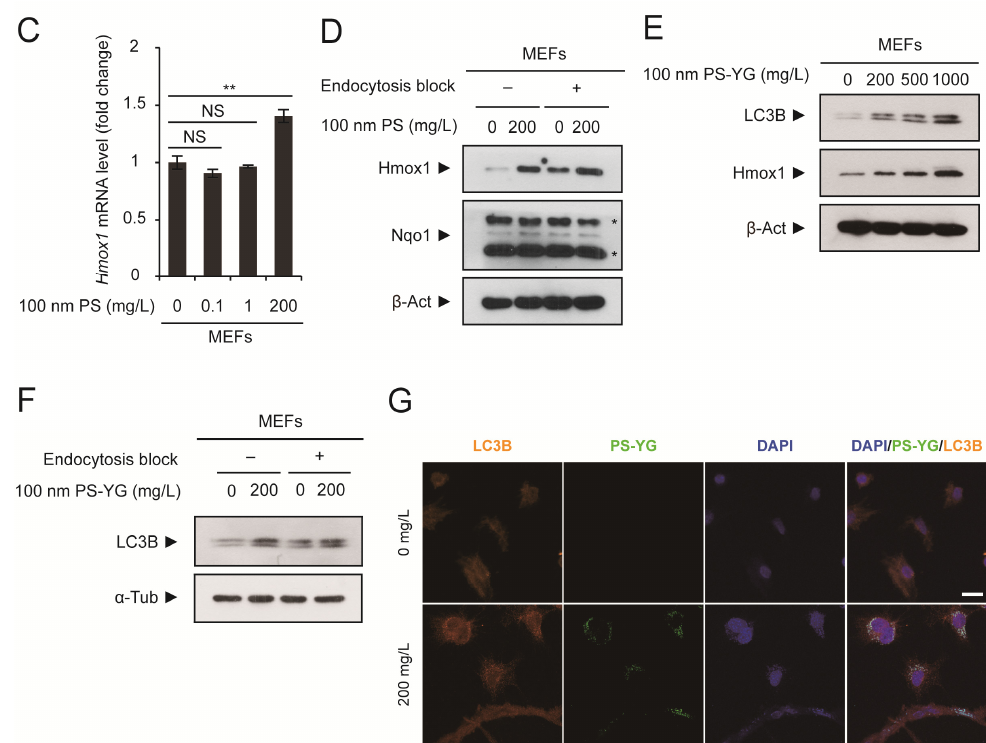
Figure 2. Stress response in MEFs caused by the intracellular accumulation of PS nanoplastics. ( A , C ) MEFs were treated with 100 nm PS nanoplastics at the indicated concentration for 2 days. mRNA expression levels of tumor necrosis factor- α ( Tnfa ), interleukin-1 β ( Il1b ), and heme oxygenase1 ( Hmox1 ) were determined by qRT-PCR ( n = 3 each), normalized against Gapdh levels, and expressed as the fold change relative to untreated control levels. ( B ) MEFs were treated with PS nanoplastics at the indicated concentration for 1 day with or without sodium azide pretreatment to block endocytosis. ROS generation was detected using dichlorofluorescein diacetate (DCFDA)-based ROS detection assay kit. ( D , F ) Immunoblot detection of Hmox1, Nqo1, and LC3B in MEFs treated with PS or PS-YG at the indicated concentration for 1 day with or without sodium azide pretreatment to block endocytosis. β -Actin ( β -Act) or α -tubulin ( α -Tub) was used as a loading control. Asterisks (*) in Nqo1 immunoblot indicate non-specific bands. ( E ) Immunoblot detection of LC3B and Hmox1 in MEFs treated with PS-YG at the indicated concentration for 2 days. β -Actin ( β -Act) was used as a loading control. ( G ) MEFs were treated with 100 nm PS-YG nanoplastics at the indicated concentration for 2 days. Cells were subjected to immunofluorescence analysis using an anti-LC3B antibody and DNA was visualized with DAPI. Direct fluorescence from PS-YG nanoplastics was also visualized. Representative immunoblots or images of cells are shown. qRT-PCR and ROS detection data are expressed as the means ± SEM from the indicated number of samples. * p < 0.05; ** p < 0.01; *** p < 0.001 vs. control (0 mg/L) or between two groups, as indicated by horizontal bars. NS, not significant. Scale bar, 50 μ m.